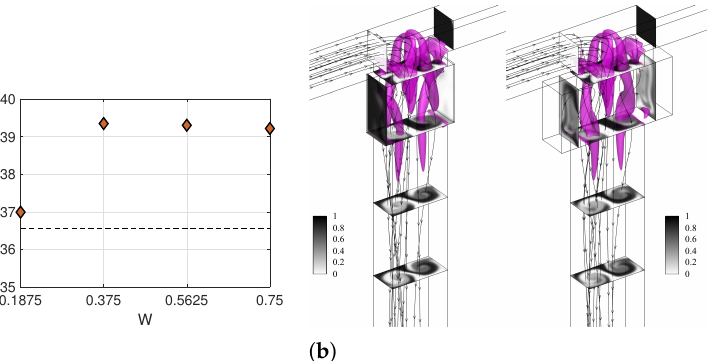
Figure 7. ( a ) Degree of mixing of the T-microchannel with different cavity width ( W ) at Y = − 8. ( b ) Isosurfaces of the λ 2 vortex-indicator and contours of non-dimensional dye concentration at the Y = 0.375, − 1.875, − 3.375, and − 4.874 cross-sections along the outlet channel for geometries with the shortest (left panel) and longest (right panel) length W , i.e., Case W.1 W = 0.1875 and Case W.3 W = 0.75, respectively, at Re = 200.